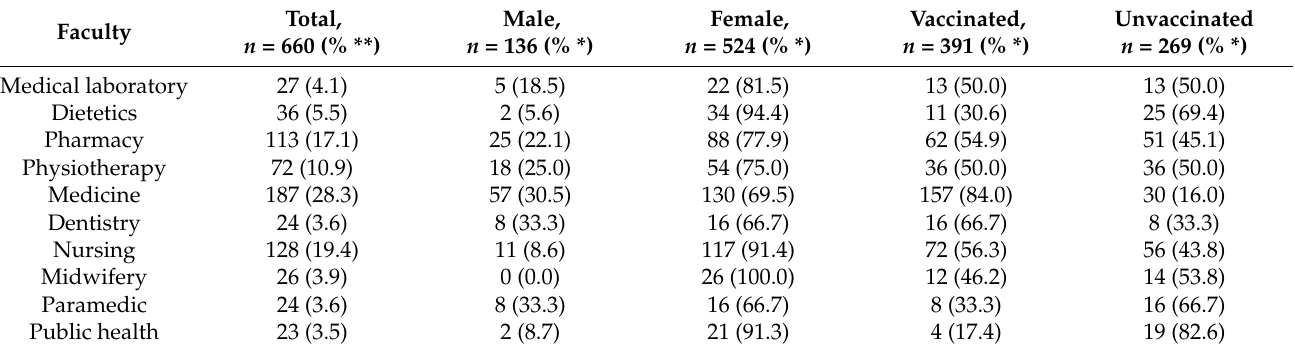
Table 2. Characteristics of study participants based on their faculty, gender, and vaccination